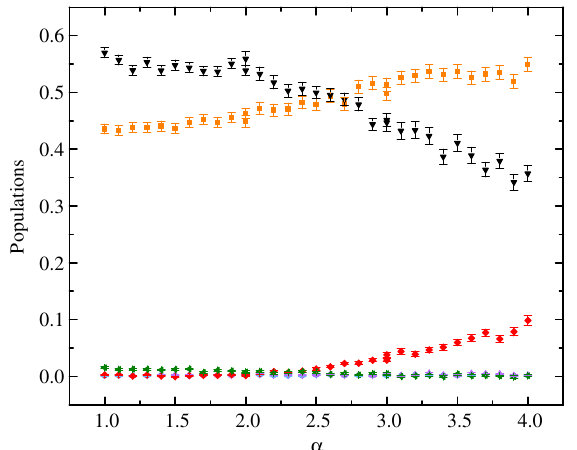
FIG. 14. Optimization of the first lobe of the cat state pulse. Populations of the level m 1 , m 2 , m 3 , e 2 , e 1 , and c as a function of the scaling factor α with which we amplify the first 4 ns of the pulse. Increasing α increases the final population of 52 m 1 and decrease the final population of 52 c (until eventually the SCS part of the wave function no longer reaches the north pole at the end of the pulse, leading to an increase of P e 1